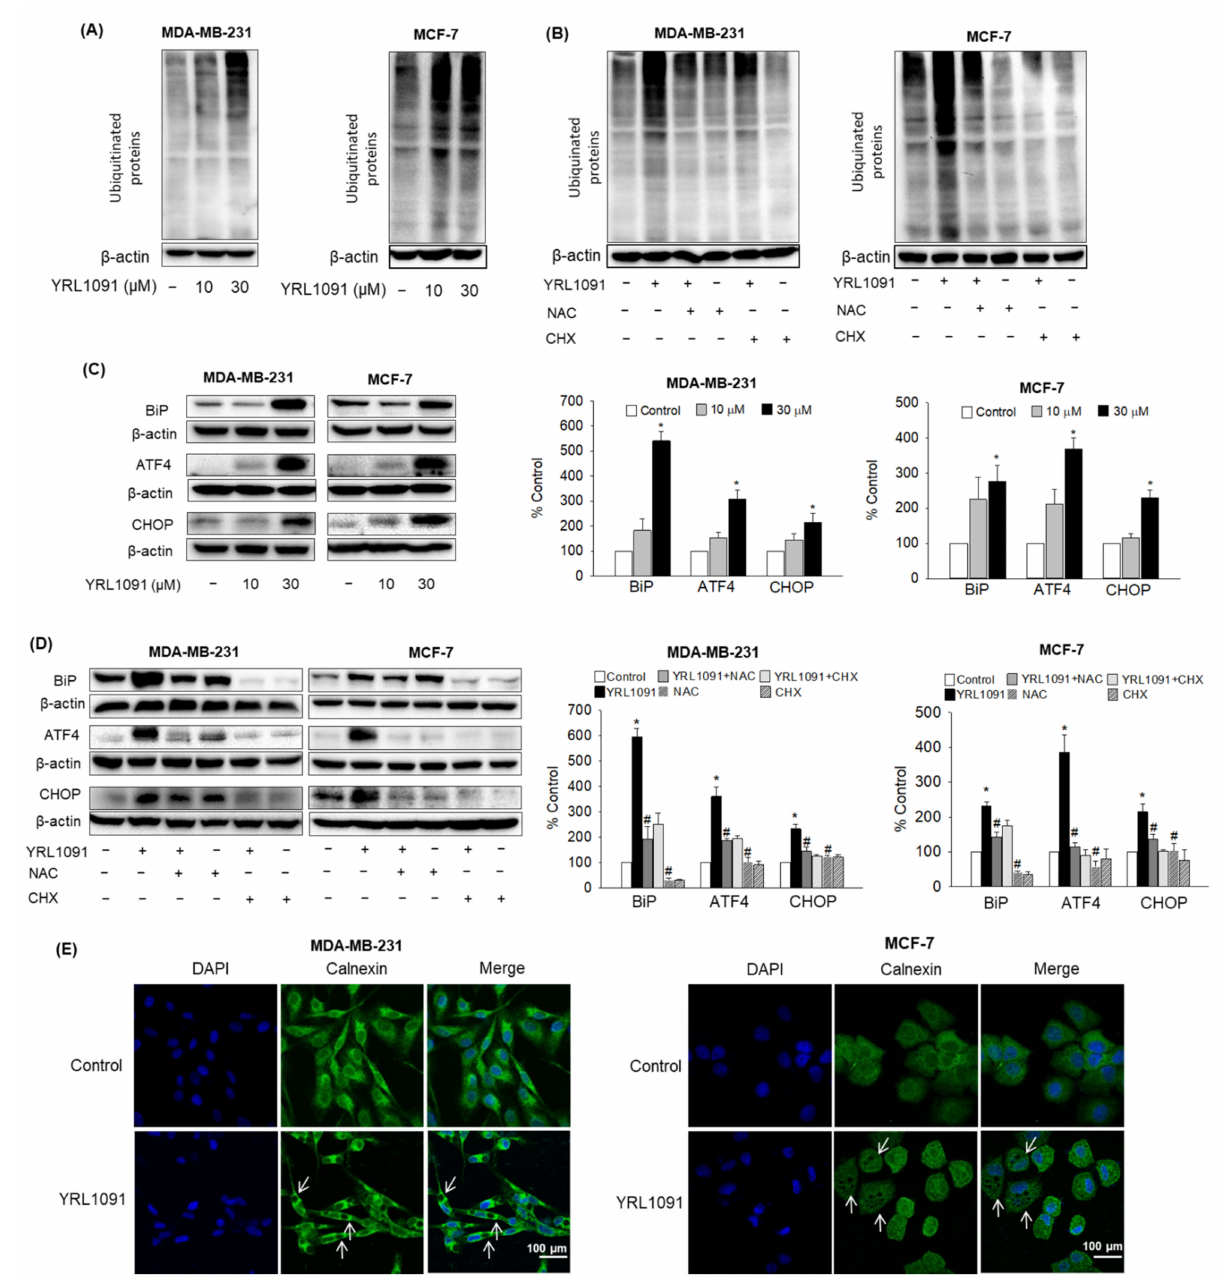
Figure 10. Induction of ER stress by YRL1091 and the origin of vacuoles in MDA-MB-231 and MCF-7 cells. ( A , C ) Cells were treated with YRL1091 (10 and 30 µ M) for 24 h. ( B , D ), Cells were pretreated with 10 mM NAC or 2 µ M CHX for 2 h, and then exposed to 30 µ M YRL1091 for 24 h. After the desired treatments, immunoblotting analyses were performed using anti-poly-ubiquitinated protein antibody ( A , B ) or anti-BiP, -ATF4, and -CHOP antibodies ( C , D ). Each data point was calculated as the percentage of protein level in vehicle-treated control cells. Representative blots and relative levels of the respective protein from at least three independent experiments were displayed. Data are presented as the mean ± SEM from at least three independent experiments.* p < 0.05 vs. vehicle-treated control cells; # p < 0.05 vs. YRL1091-treated cells. ( E ) Cells were treated with 30 µ M YRL1091 and stained with calnexin as described in Materials and Methods. Representative immunofluorescence images are shown. Scale bar: 100 µ m. The white arrows indicate representative cytoplasmic